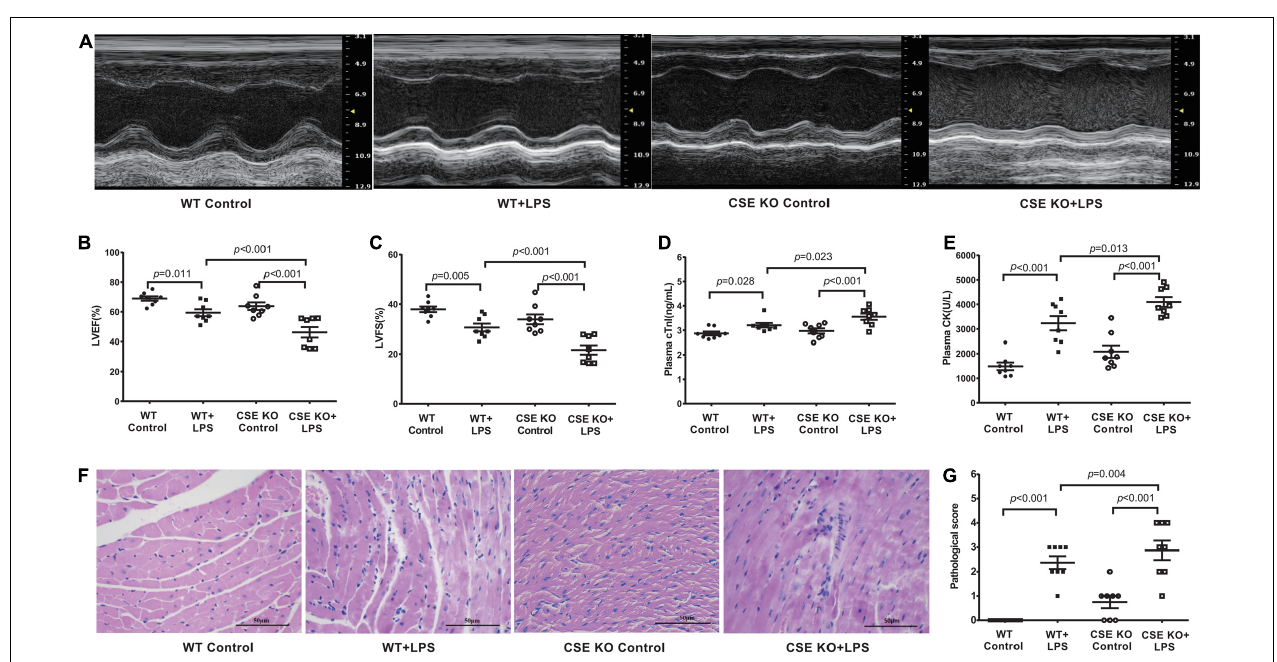
FIGURE 3 | Loss of endogenous H 2 S aggravated LPS-induced myocardial dysfunction: (A) Representative M-mode images from WT Control, WT + LPS, CSE KO Control, and CSE KO + LPS groups. (B) The changes of left ventricular ejection fraction (LVEF). (C) The changes of left ventricular fractional shortening (LVFS). (D) cTnI levels in the plasma. (E) CK levels in the plasma. (F) Representative HE-stained left ventricular sections (scale bar = 50 µ m). (G) Pathological score of the HE-stained left ventricular sections. n = 8 in every group. Results are means ± SEM. p < 0.05 was considered significant.